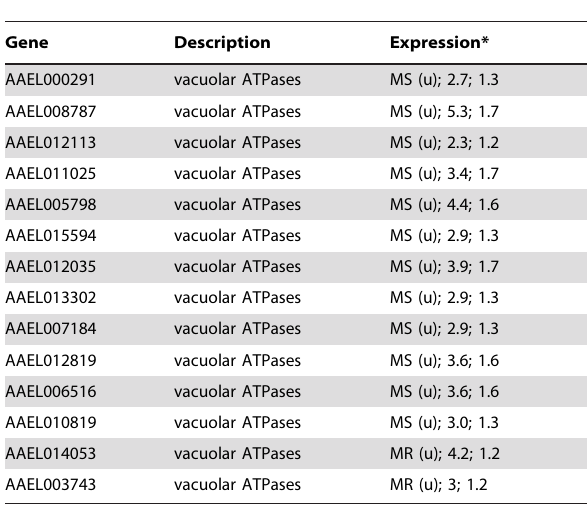
Table 6. List of cuticle protein